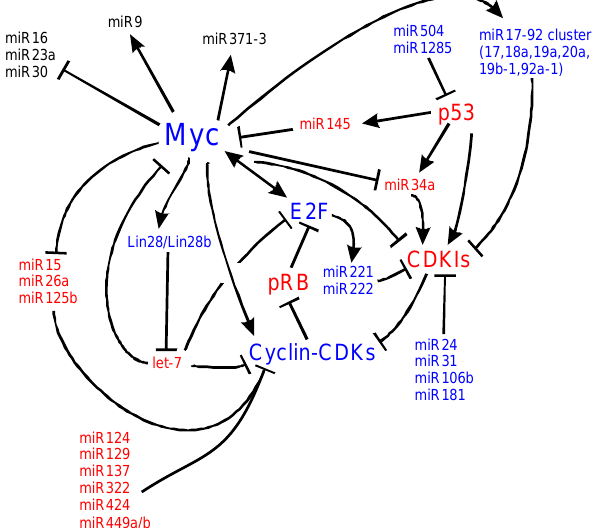
Figure 7. Myc is a highly regulated transcription factor that plays roles in stem cell maintenance and proper hair cell